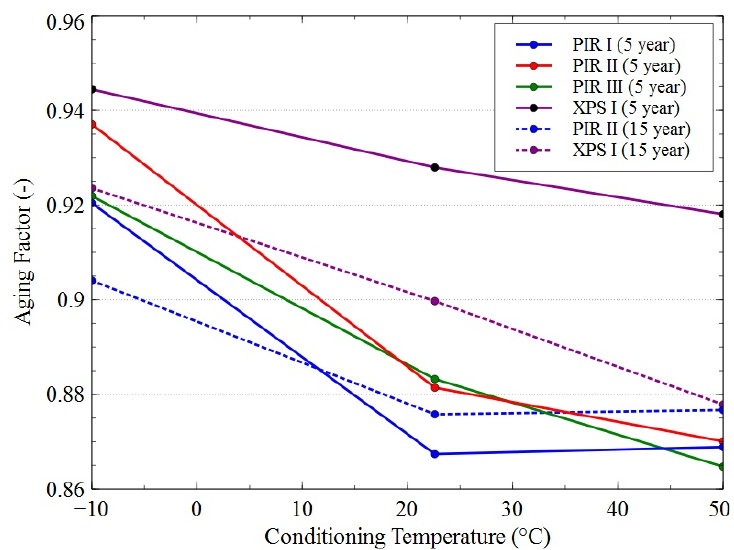
Figure 1. Effect of conditioning temperature on aging factor at a mean temperature of 24 ◦